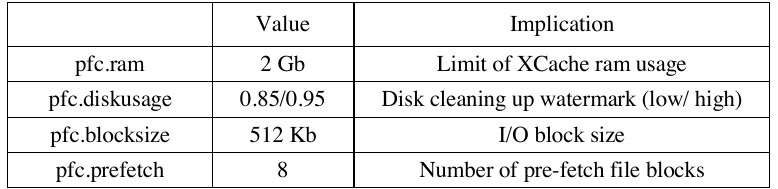
Figure 1. Overview of the XCache testbed